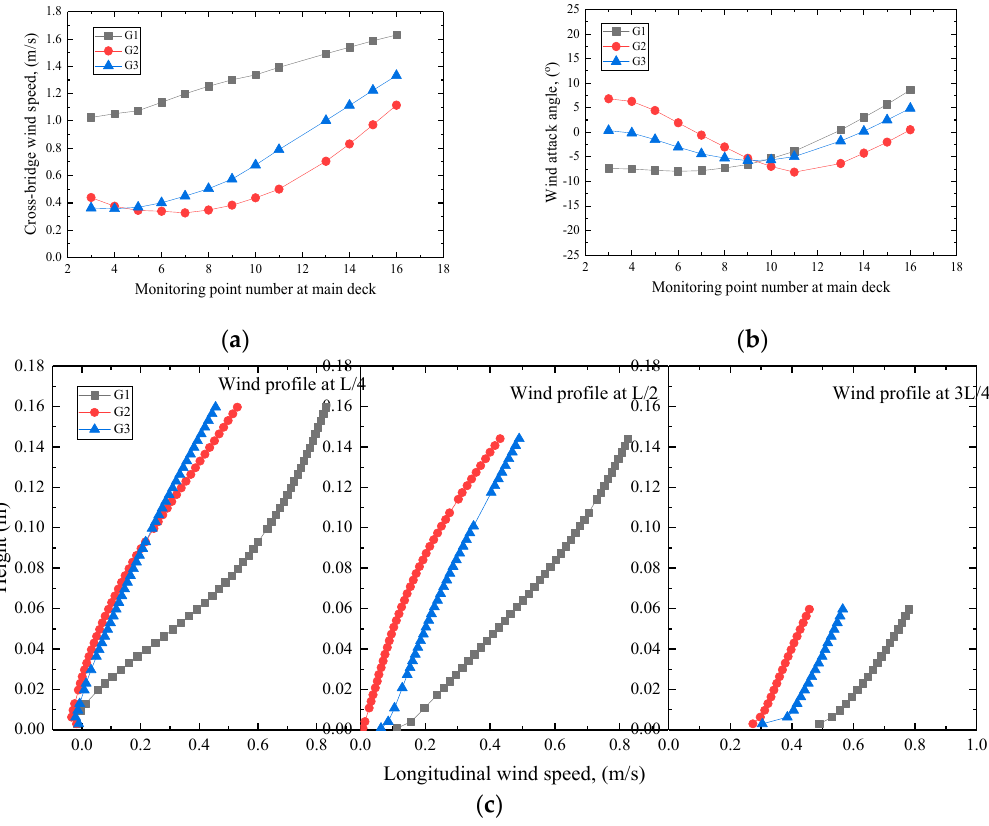
Figure 7. Comparisons for average wind characteristics with different grid generations. ( a ) Mean cross-bridge wind speed at main deck level; ( b ) Wind attack angle at main deck level; ( c ) Longitudinal wind speed profiles at L/4, L/2 and 3L/4 of the bridge length.